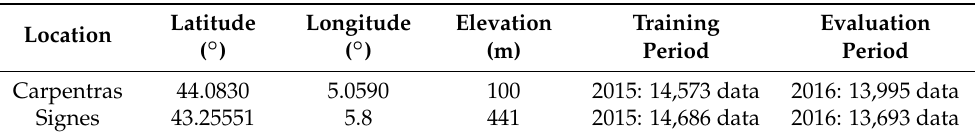
Table 1. Summary of the sites location and description of the yearly dataset of measured 15-min GHI used for training and for evaluation.